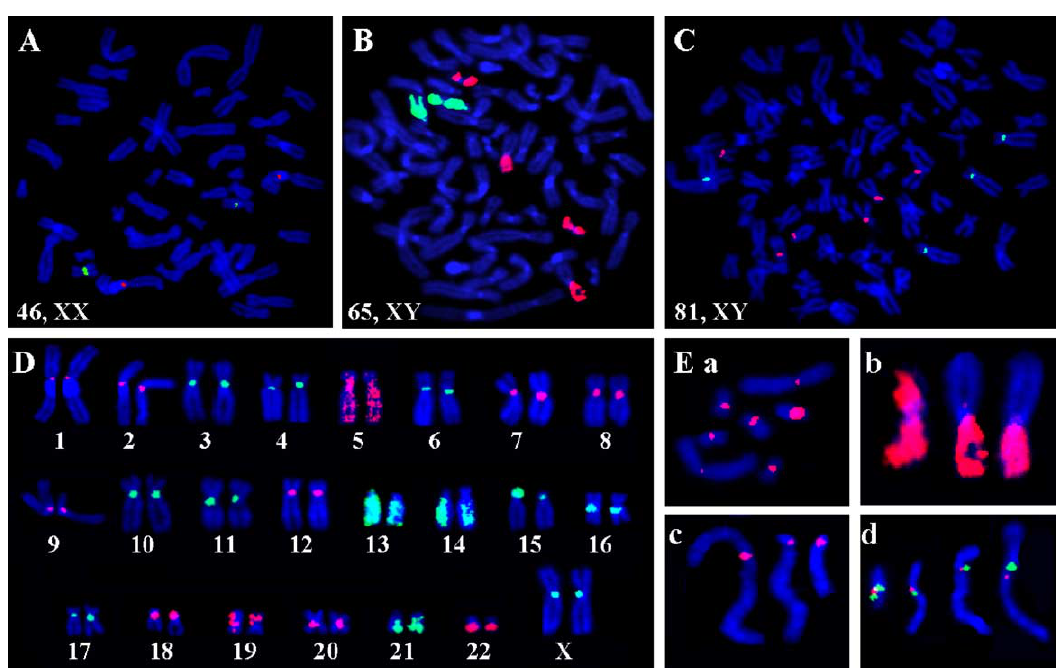
Fig. 1. Localization of chromosome specific FISH probes in DAPI-stained karyotypes. The diploid CCD-34Lu (A), and aneuploid A549 (B) and SUIT-2 (C) cell lines were hybridized with specific centromeric and paint DNA probes specific for chromosomes (1 red, 16 green), (19 red, 13 green) and (17 red, 4 green) respectively. (D) A composite karyotype of FISH-identified chromosomes of the diploid CCD-34Lu line. (E) FISH-localization’s of (a) extrachromosomal fragments (ECF’s) found in the aneuploid SUIT-2 line showing two normal centromeric local- ization’s of the FISH probes for chromosome 1 and in five ECF’s from the same karyotype. (b) Normal chromosome 19 paint localization next to chromosome 19 breaks and refusions to another chromosomes(s) found in the same karyotype of the aneuploid A549 line. (c) Centromeric localization of the FISH probe in a normal chromosome 2 and in several abnormally placed, telomeric regions classified as END’s in the same karyotype of the A549 line. (d) Fusion’s found in both aneuploid cell lines with centromeric chromosome probes labeled in red (r) and green (g) from left to right: 18r/16g, 7r/10g, 20r/9g, and 18r/10g. (Reproduced, with permission from Isaka, T., Nestor, A.L., Takada, T. and Allison, D.C. Chromosomal variations within aneuploid cancer lines. J Histochem Cytochem , 51 , 1343–53, 2003.)